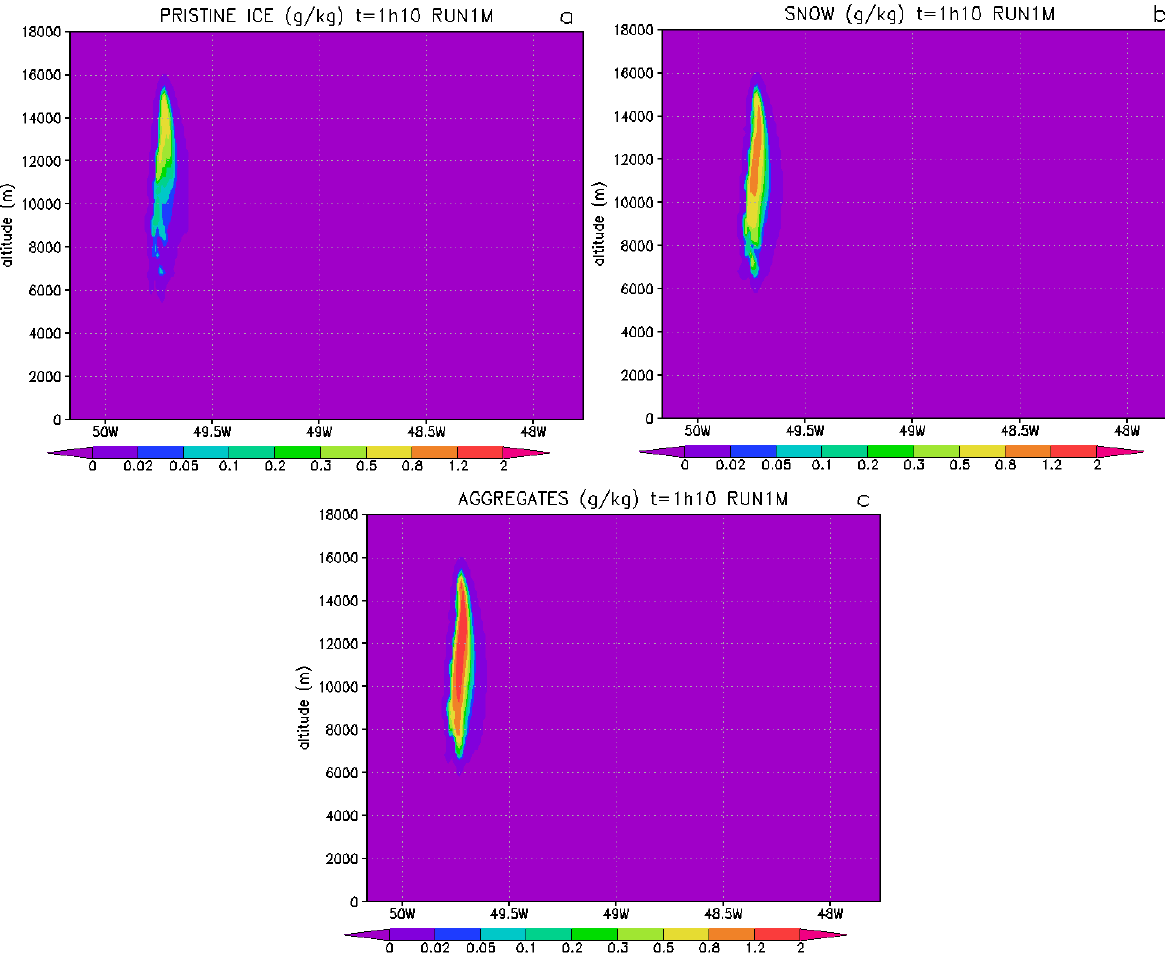
Fig. 2. Same as Fig. 1 but for the RUN1M